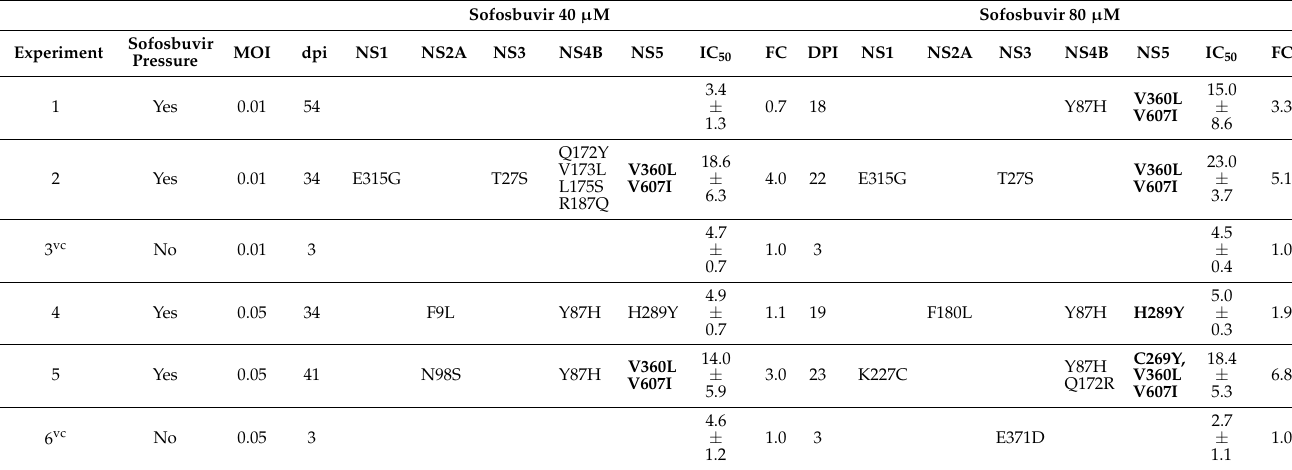
Table 1. Reduction of sofosbuvir activity in mutated viral stocks at 40 and 80 µ M drug pressure. In bold are indicated the mutations detected both by Sanger sequencing and by Next Generation Sequencing (NGS). Exp—experiment; MOI— Multiplicity of infection; IC 50 —half-maximal inhibitory concentration, each value is expressed in µ M and is the mean of triplicate assays ± standard deviation; FC—Fold change; dpi—days post infection; VC—virus control. No variations with respect to the wild type (WT) sequence were detected in NS4A and NS2B regions, thus, it is not indicated in the table. Sofosbuvir 40 µ M Sofosbuvir 80 µ M Experiment Sofosbuvir